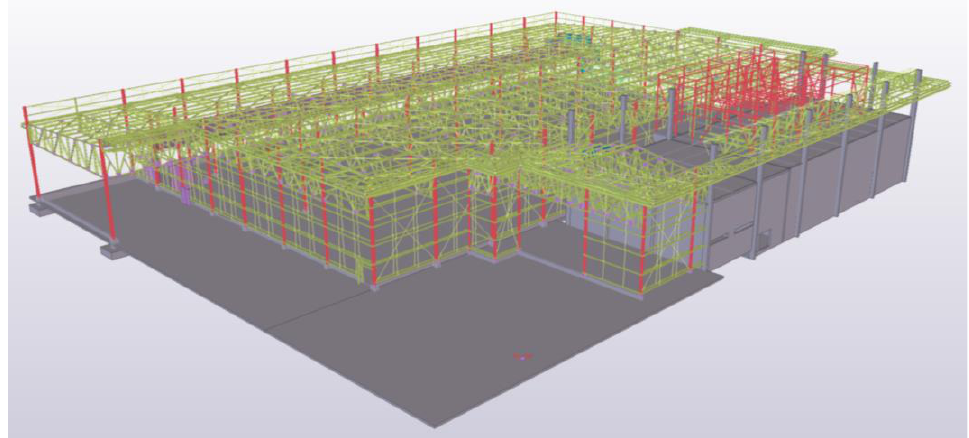
Figure 10. BIM estimation model sample.